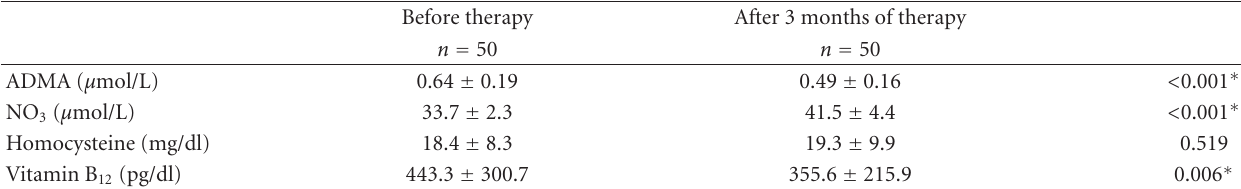
Table 3: ADMA, NO 3 , homocysteine, and vitamin B 12 levels in patients (before and after 3 months of anticoagulant therapy).